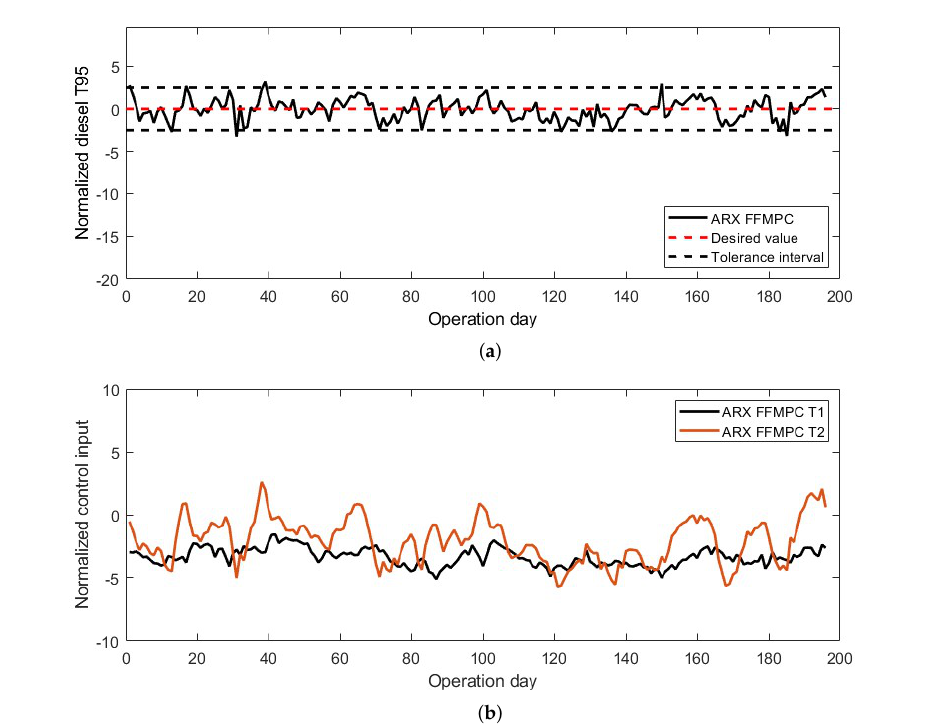
Figure 11. Diesel quality and reactor temperatures estimated with the ARX model. ( a ) Diesel T95 estimations. ( b ) Suggested reactor temperatures.